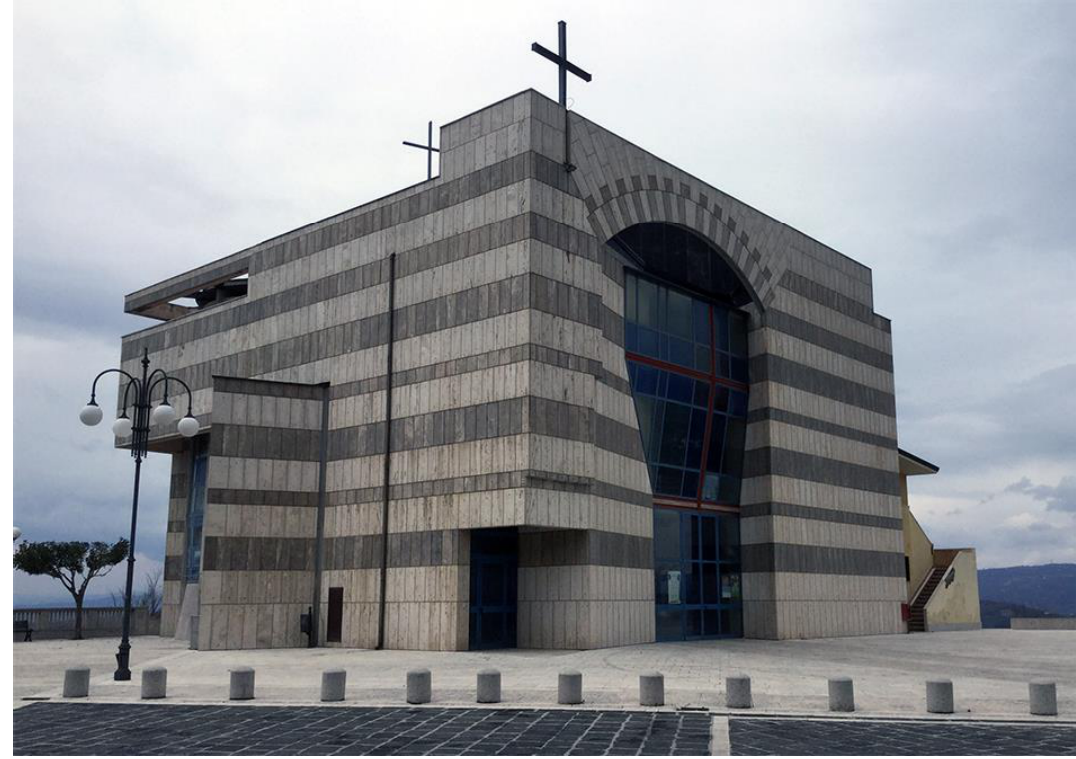
Figure 55. San Mango sul Calore: Panoramic view of the village completely rebuilt after the 1980 earthquake (photos by [35,36]).